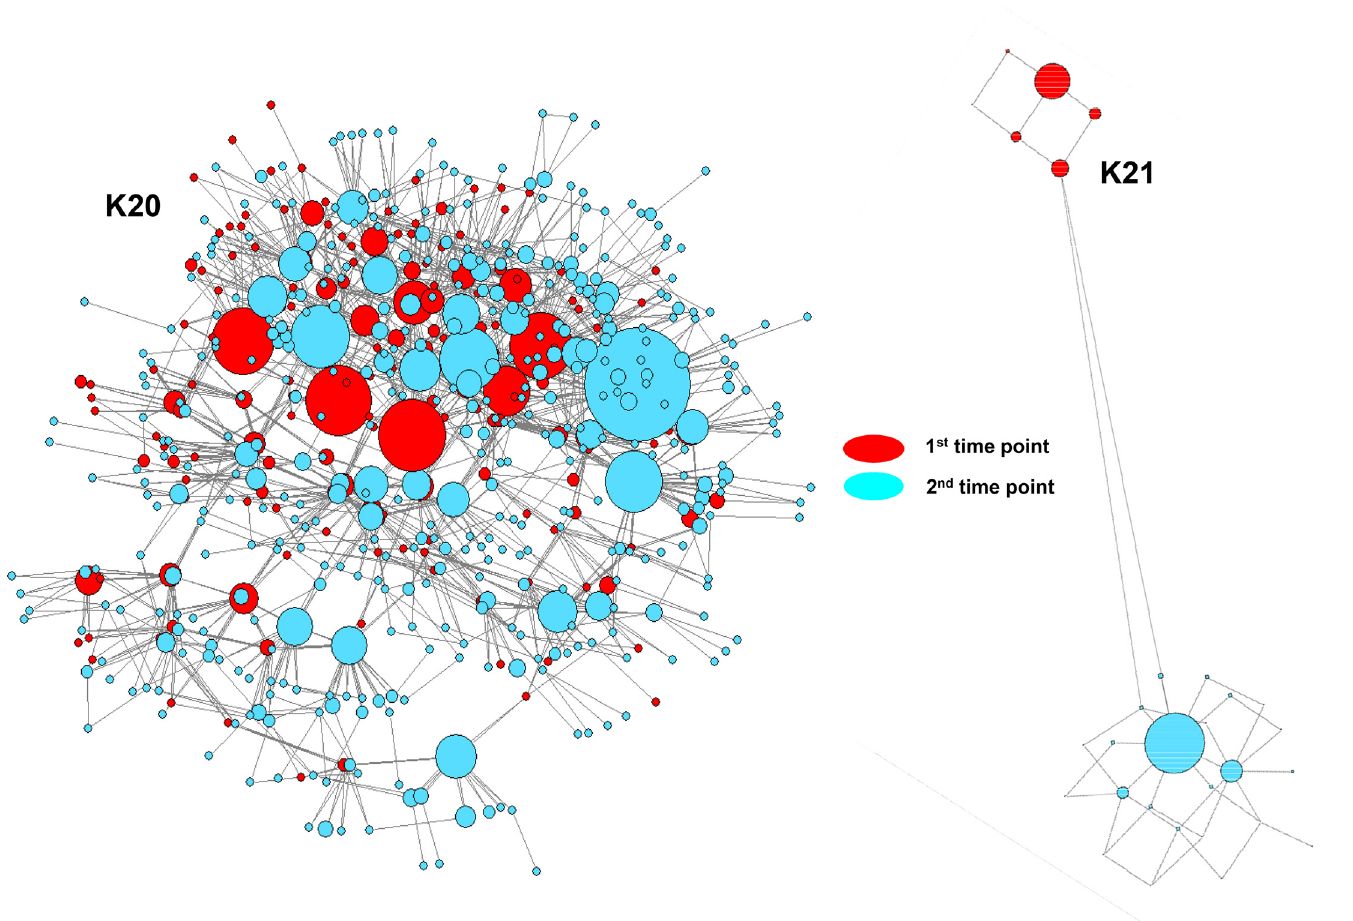
Fig 5. PFnet of all sequences present in two patients at different time points. Each time point is shown with a different color. Sequences found on the first time point are shown in red and the second time point in blue. Each node represents a single sequence variant. The size of the node reflects frequency of the corresponding variant in the population. This network includes all of the links in any minimum spanning tree. The time interval between each time point is ~2